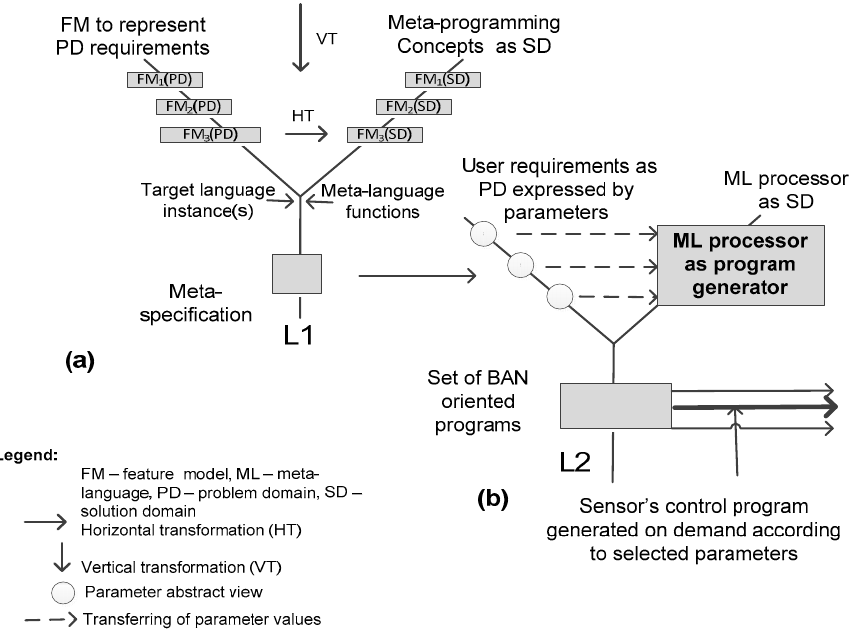
Figure 4. Principle of model-driven methodology: ( a ) transformation-based framework; ( b ) automatic design of BAN-oriented software.